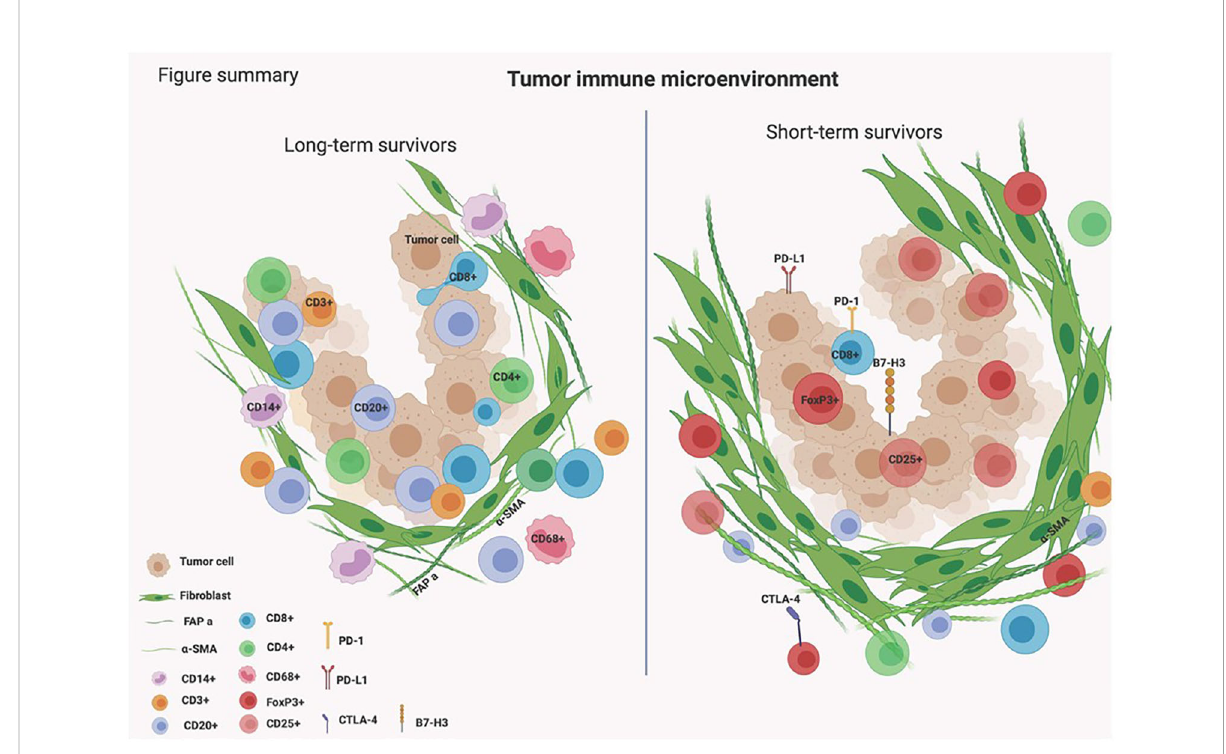
FIGURE 5 Schematic presentation of the TIME in long- and short-term survivors of PDAC